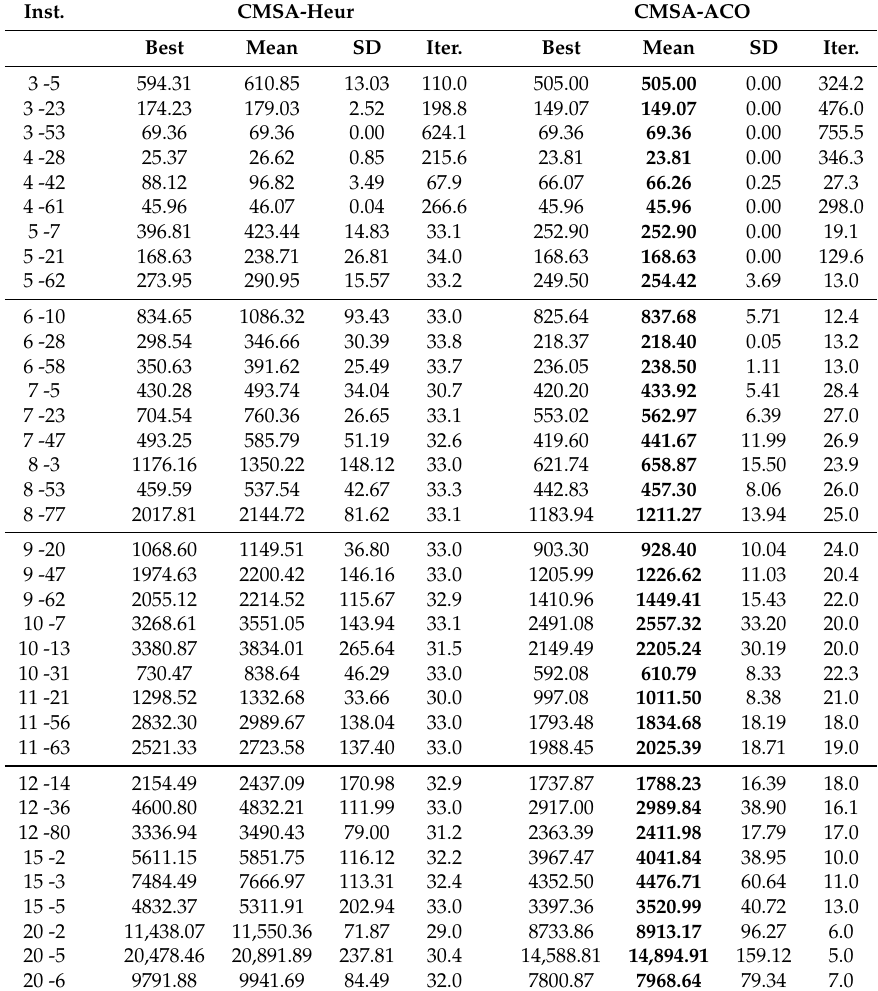
Table 2. CMSA with ACO. For 25 runs conducted, the best ( Best ) and average ( Mean ) solution qualities with associated standard deviations ( SD ) are provided. The table also shows the average number of iterations ( Iter .) conducted for each problem instance. Statistically significant results, using a pairwise t -test, at the 95% confidence interval are highlighted in boldface.